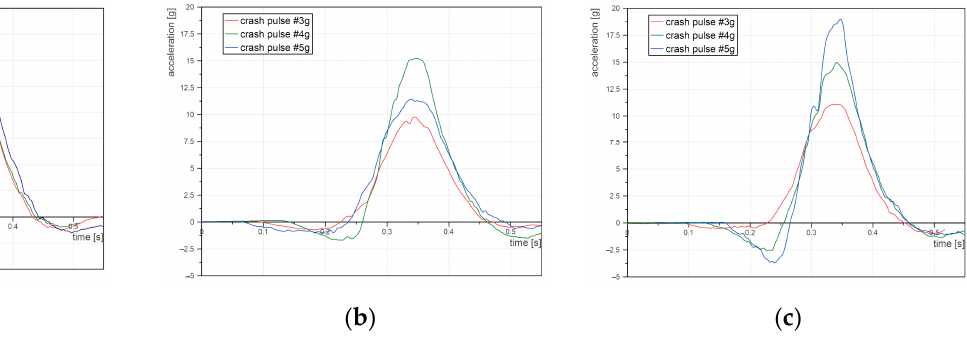
Figure 4. Head acceleration of the dummy: ( a ) seatback angle 110°; ( b ) seatback angle 130°; ( c ) seat- back angle 145°.